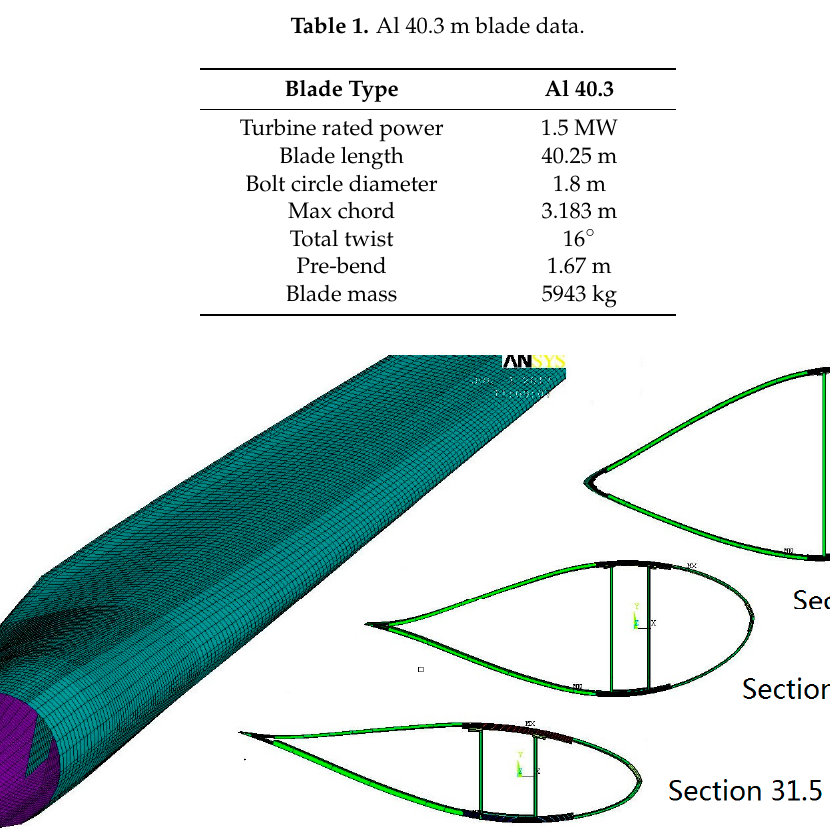
( b ) Figure 7. The resonant Bode diagram. ( a ) Amplitude-frequency diagram; ( b ) Phase-frequency diagram. 4.2. Phase Coupling The excitation forces of exciters A and B are 1000 N and 300 N, respectively. When the damping ratio is 0.25%, the relationship between the dual exciters at different phase differences and the vibration amplitude of the blade is as shown in Figure 8. When the phase difference is at 60°, the amplitude decreases by 15%. The excitation effect driven by the excitation exciters A and B cancel each other out at 180°. The excitation effect of exciting force 300 N placed at 24 m is equivalent to an excitation force of 1000 N placed at 16.5 m.